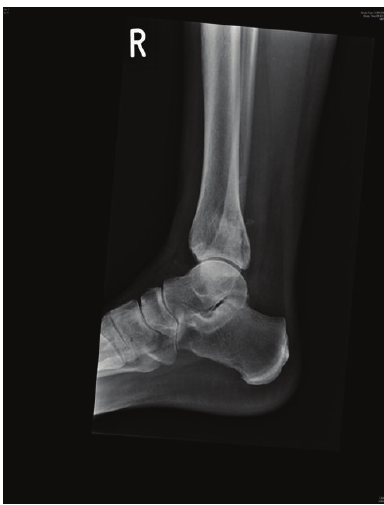
Figure 7: Lateral view X-ray at follow-up showing complete incor- poration of graft and healing of